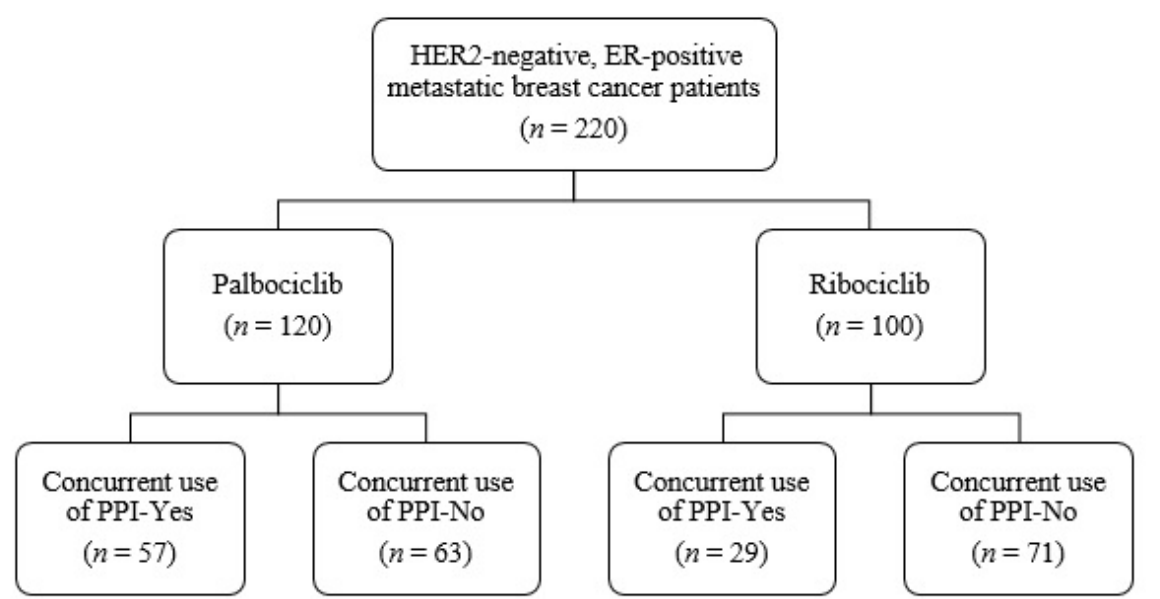
Figure 1. Flow chart of the study participants. Abbreviations: ER, estrogen receptor; HER2, human epidermal growth factor receptor 2; PPI, proton pump inhibitor. Table 1. Clinical characteristics of patients and their distribution across PPI groups.